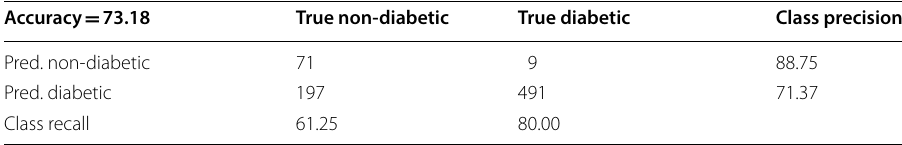
Table 6 Results of decision tree